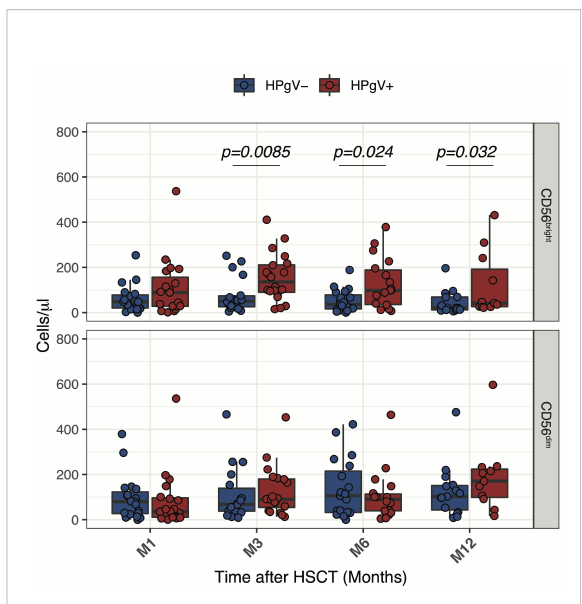
FIGURE 3 Impact of HPgV-1 viremia on NK cell subsets reconstitution after allogeneic HSCT. Absolute numbers of CD56bright and CD56dim NK cell subsets through one-year post-transplantation in HPgV-1-viremic (HPgV+; red fi lled symbols) and HPgV-1-non viremic (HPgV-; blue fi lled symbols) HSCT recipients. Results in the two patient groups were compared using a nonparametric Mann-Whitney U